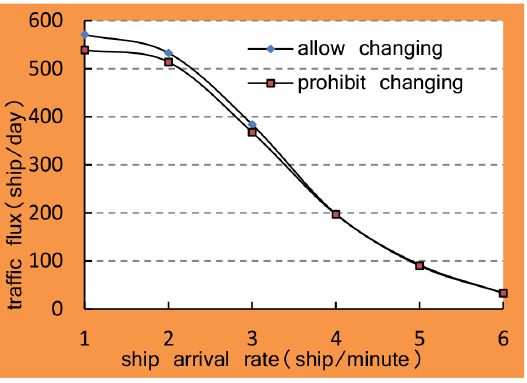
Figure 8. Traffic flux and ship arrival rate as a function when inbound and outbound ship arrival rates are symmetrical